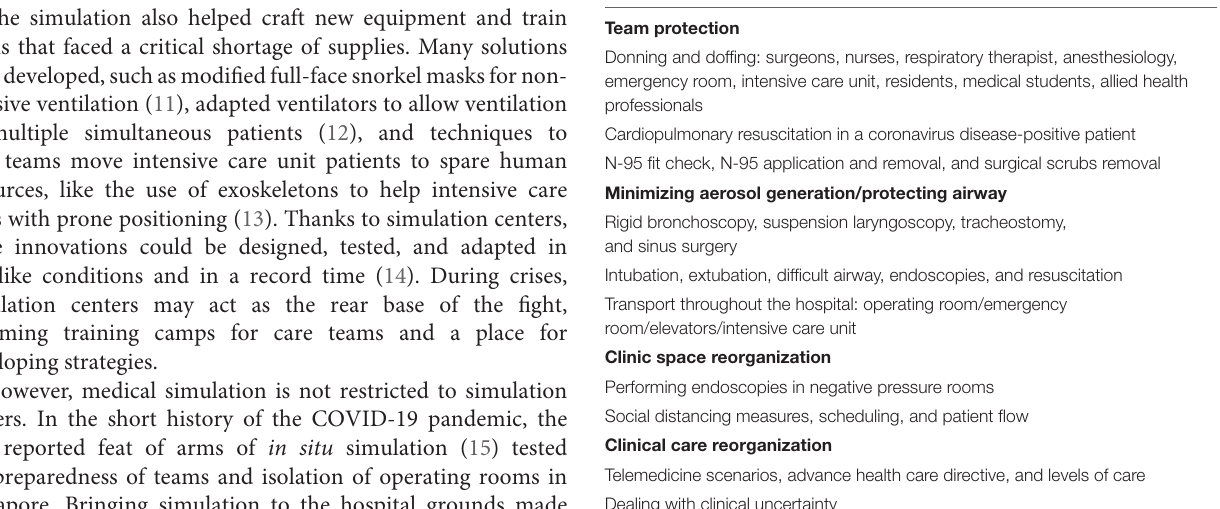
TABLE 1 | In situ simulation scenarios during COVID-19